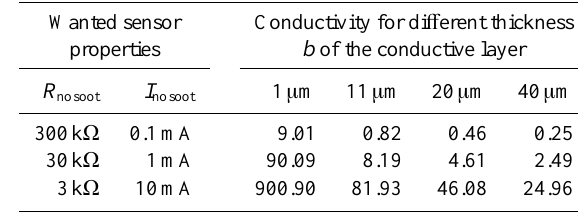
Table 1. Electrical conductivities of the conductive layer in mSm − 1 used for di ff erent layer thicknesses and base currents /